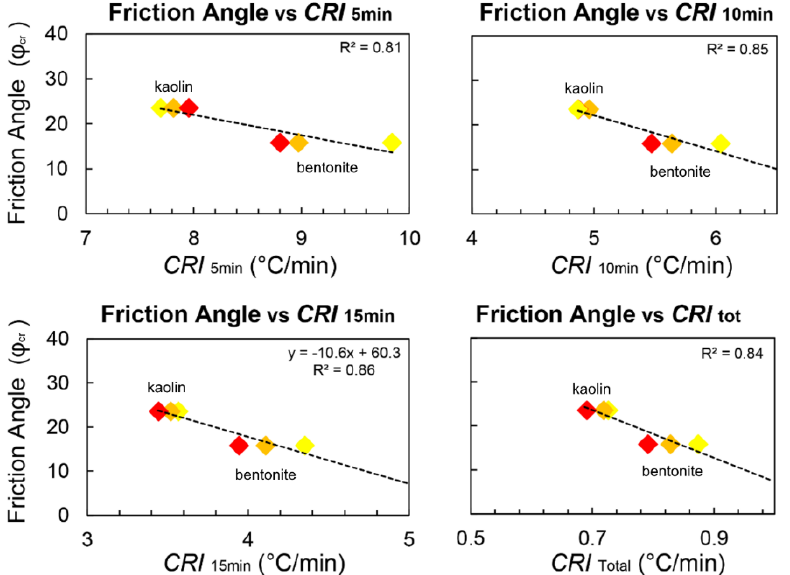
Figure 6. Linear regression analysis between the critical state friction angle (φ cr ) and the CRI according to different time intervals since the beginning of cooling: 5 min (top left); 10 min (top right); 15 min (bottom left); entire cooling phase (bottom right). The markers represent the mean values for disks of bentonite and kaolin at different porosity. Note that the values for kaolin plot in th left portion of each graph (lower CRI), while those for bentonite plot in the right portion (higher CRI).